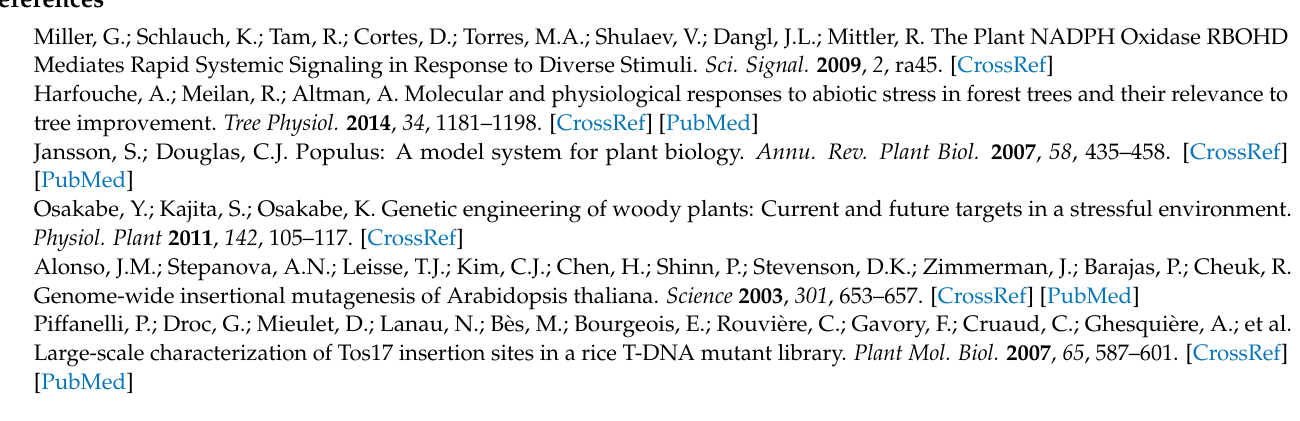
thaliana seedlings. Figure S2: Screening of salt tolerance FOX mutants. Figure S3: Phylogenetic analysis and amino acid alignment of PtoCPCa and other R3 MYB transcription factors from different species. Figure S4: Phylogenetic analysis and amino acid alignment of PtoWRKY13 and other WRKY transcription factors from different species. Supplementary Data Set 1: Primers used in this